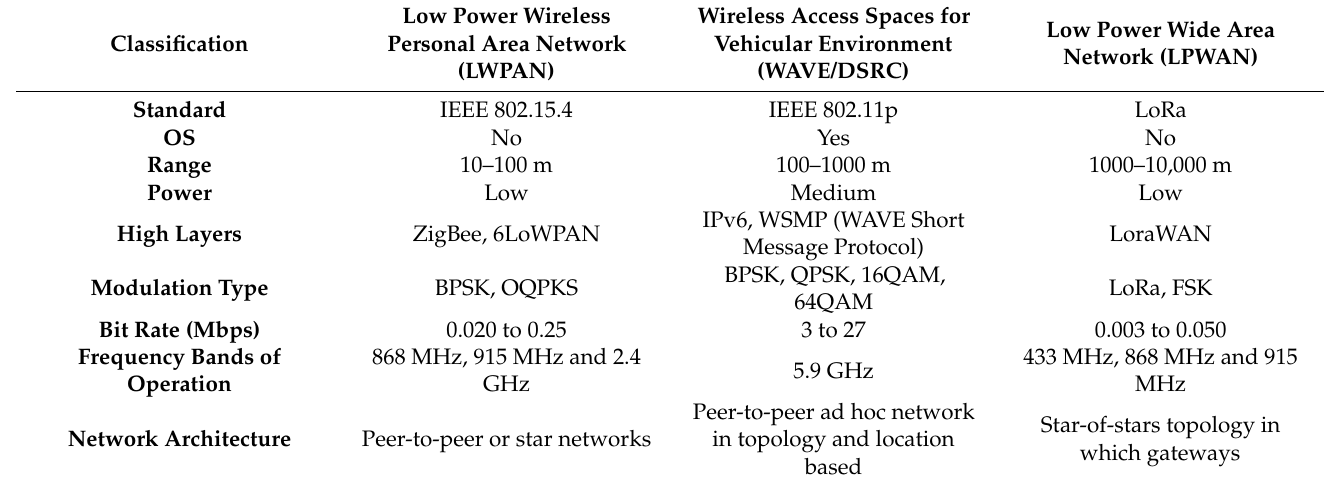
Table 9. Comparative summary of different communication